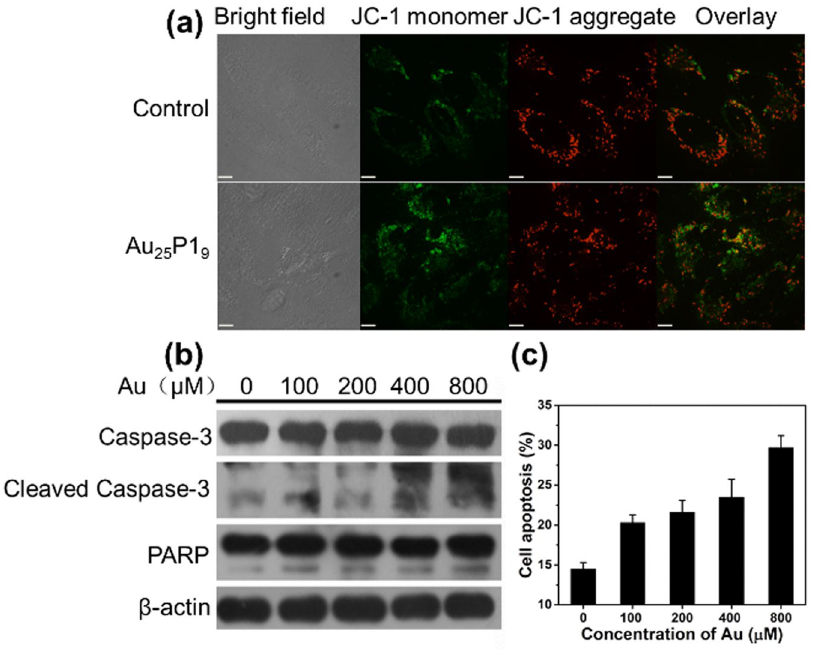
Figure 4. ( a ) CLSM images of mitochondrial membrane potential (JC-1 staining) in A549 cells pre-treated with Au 25 P1 9 at an Au dose of 800 μ M for 48 h, Scale bar is ~11 μ m. ( b ) The express level of caspase-3, PARP and β -actin extracted from A549 cells pre-treated with serial doses of Au 25 P1 9 for 48 h. ( c ) A549 cells apoptosis induced by Au 25 P1 9 in a dose-dependent